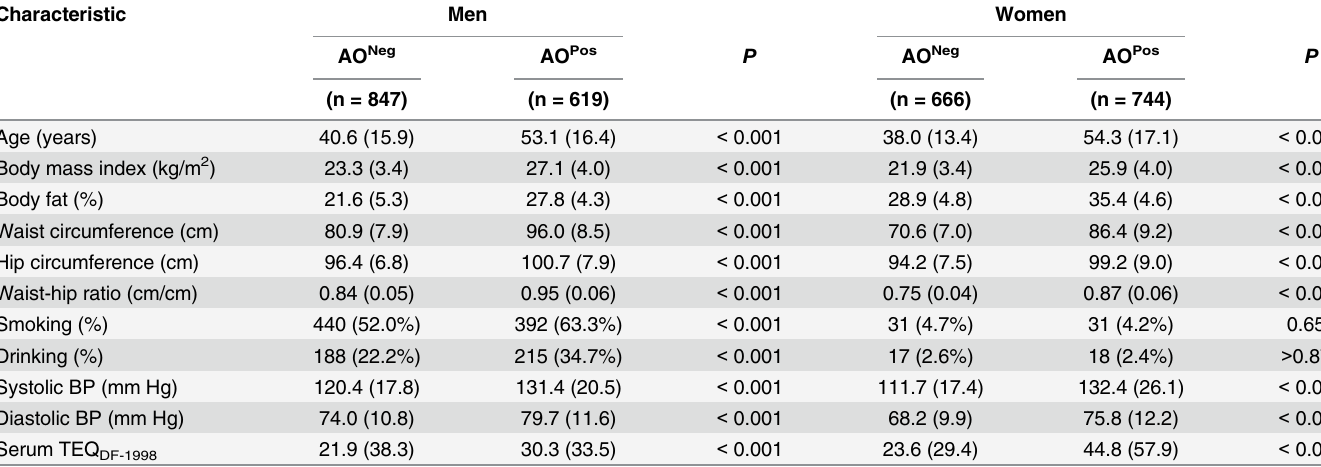
Table 1. Demographic characteristics in participants with abdominal obesity (AO Pos ) and without (AO Neg ). [Mean (SD) or Number (%)]. Characteristic